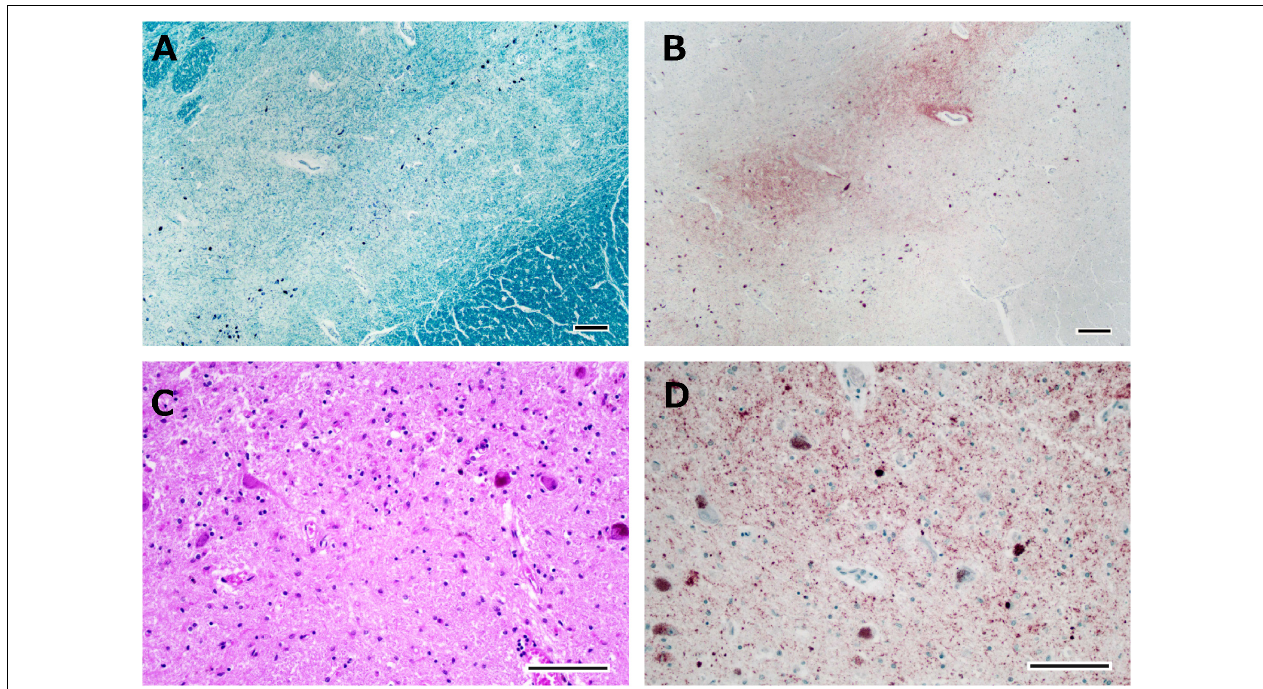
FIGURE 5 | Histological observations of the substantia nigra from Case 1. Neuronal loss is observed in the intermediate portion of the substantia nigra (A) , where phosphorylated TDP-43-positive structures are depicted (B) . Astrogliosis is severe (C) , and phosphorylated TDP-43-positive neuronal inclusions and dot-like deposits are identified (D) . Klüver-Barrera staining (A) , immunostaining for phosphorylated TDP-43 (B,D) , and hematoxylin-eosin staining (C) . Scale bars: 200 µ m (A,B) and 100 µ m (C,D)